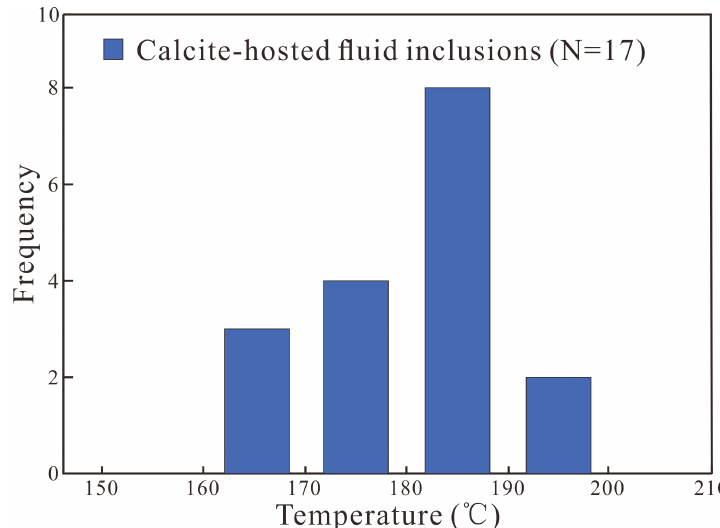
Figure 7. Histograms for homogenization temperature of fluid inclusions obtained from the Mbr 1 1 of Longmaxi Fm shale in Well H-2. N indicates the total number of fluid inclusions tested. Table 1. Analysis and calculation results of representative methane inclusions in fibrous calcite vein from Well H-2 in the Southern Sichuan Basin.